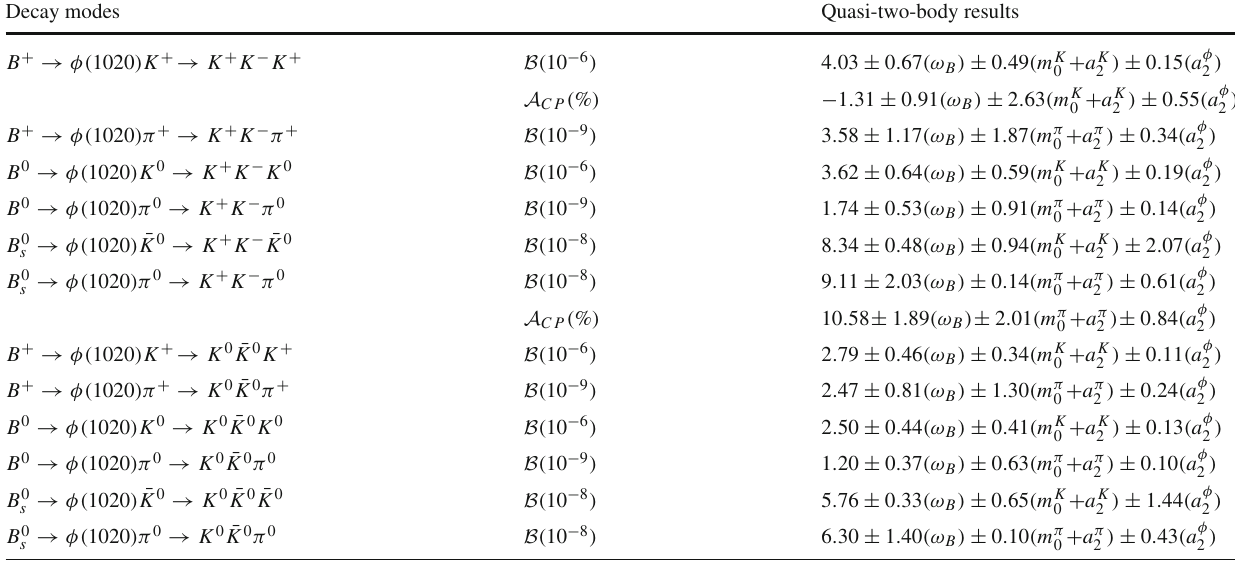
Table 2 PQCD predictions of the CP averaged branching fractions and the direct CP asymmetries for the B → φ( 1020 ) h → K ¯ Kh decays Decay modes